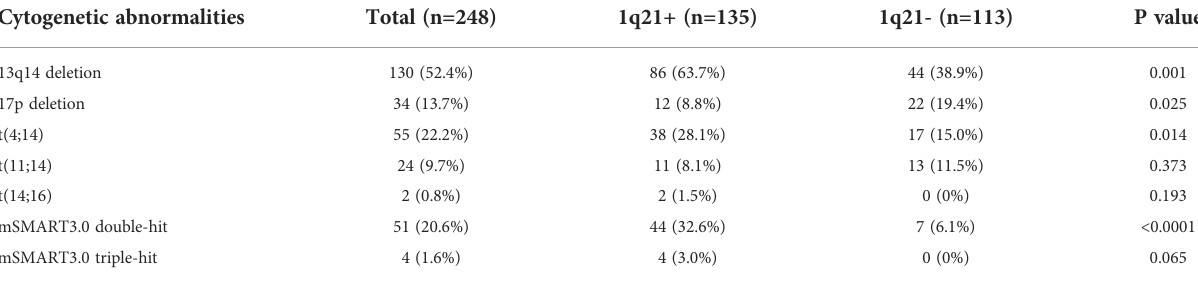
TABLE 2 Cytogenetic abnormalities of patients with total patients and 1q21+ patients detected by FISH. Cytogenetic